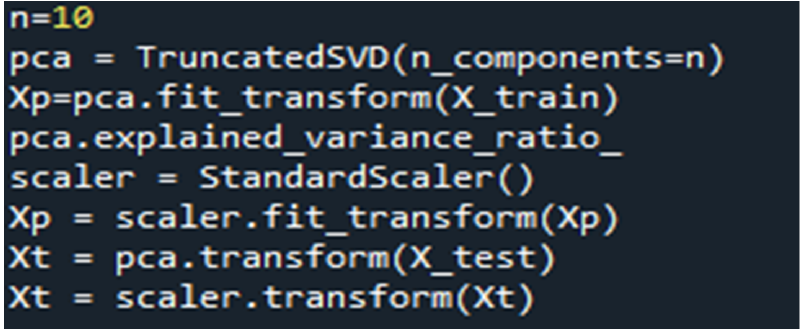
Figure 4. Python Code for Implementing the PCA Technique.